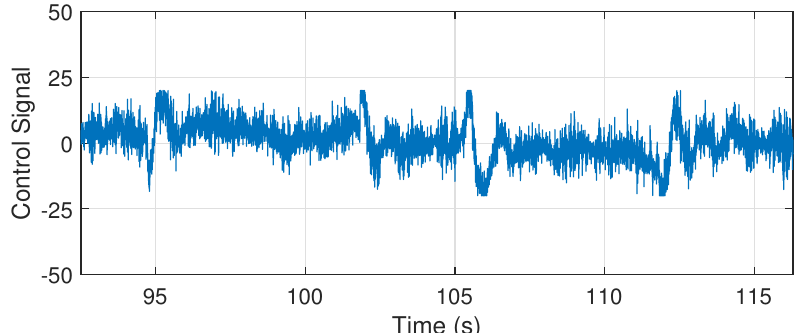
Figure 17. Pitch angular rate response.